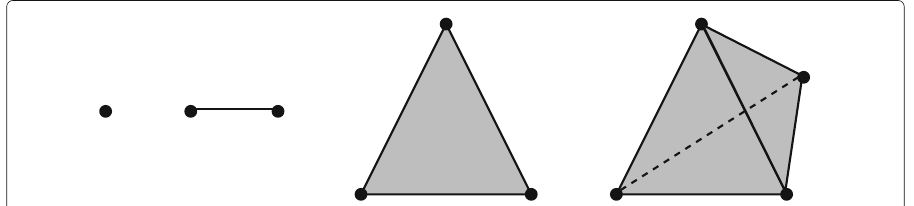
Fig. 1 0-,1-,2-, and 3-simplex from left to